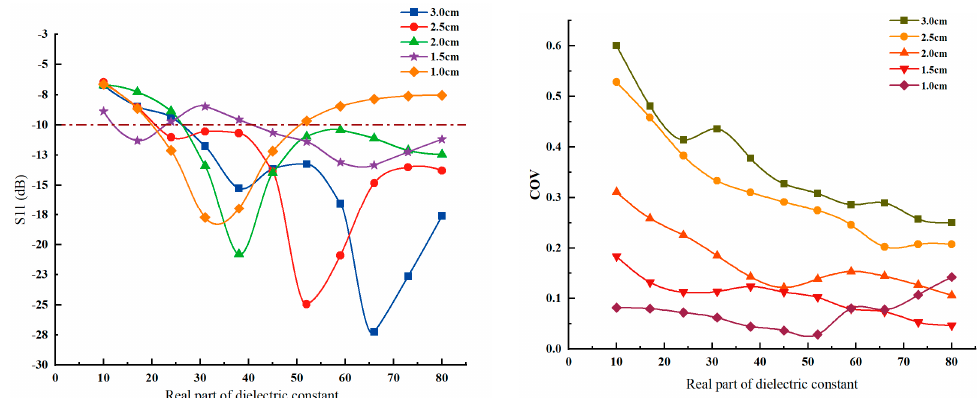
Figure 9. Effect of the real part of the dielectric constant on microwave efficiency and temperature uniformity (reflectance coefficients for different water heights are shown on the left and COV for different water heights on the right).